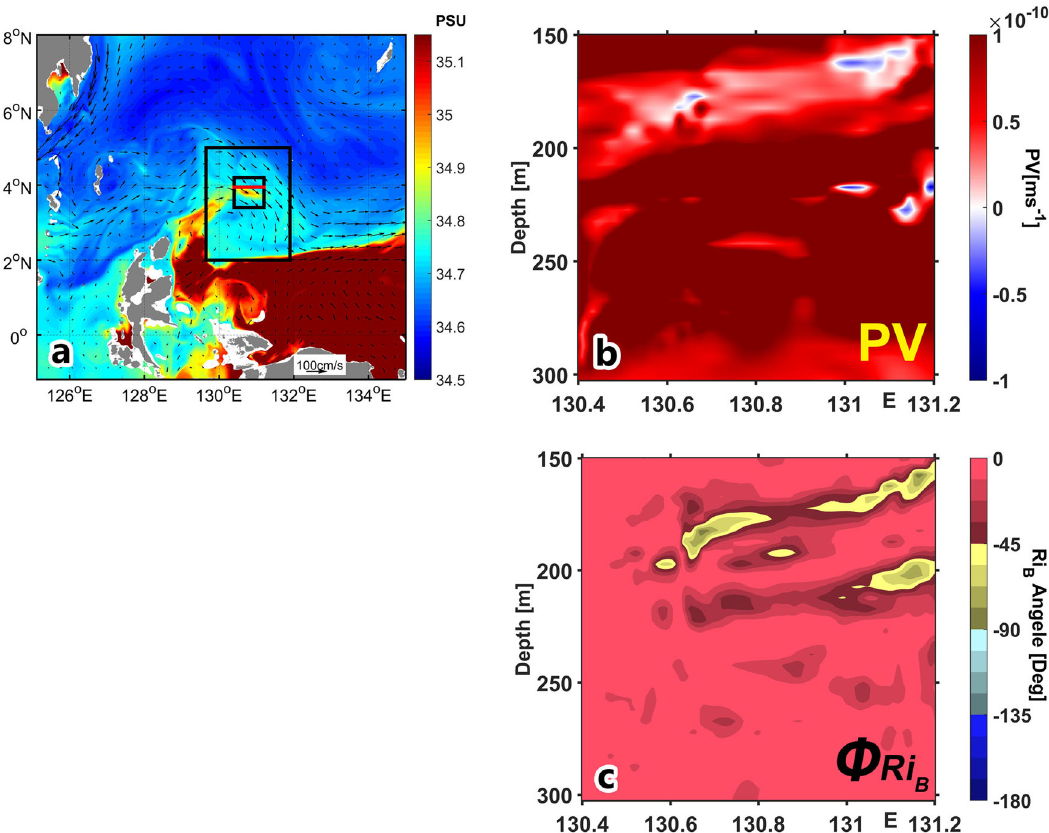
Fig. 6 Modeling the subsurface Symmetic Instability and evidence of South Paci fi c water intrusion in Northwestern Equatorial Paci fi c Ocean from observational data. a The distribution of salinity (color shading) and velocity (vectors) at 197.5 m on November 7, 2017, from the 0.008°-resolution MITgcm simulation. The two black boxes are downscaling nested domains with horizontal resolutions of 0.0025° and 0.0008°, respectively. The pro fi le of distinguishing various overturning instabilities along the transect (the red line in ( a )) from the 0.0008°- b potential vorticity (PV), c the angle + Ri B resolution simulation,